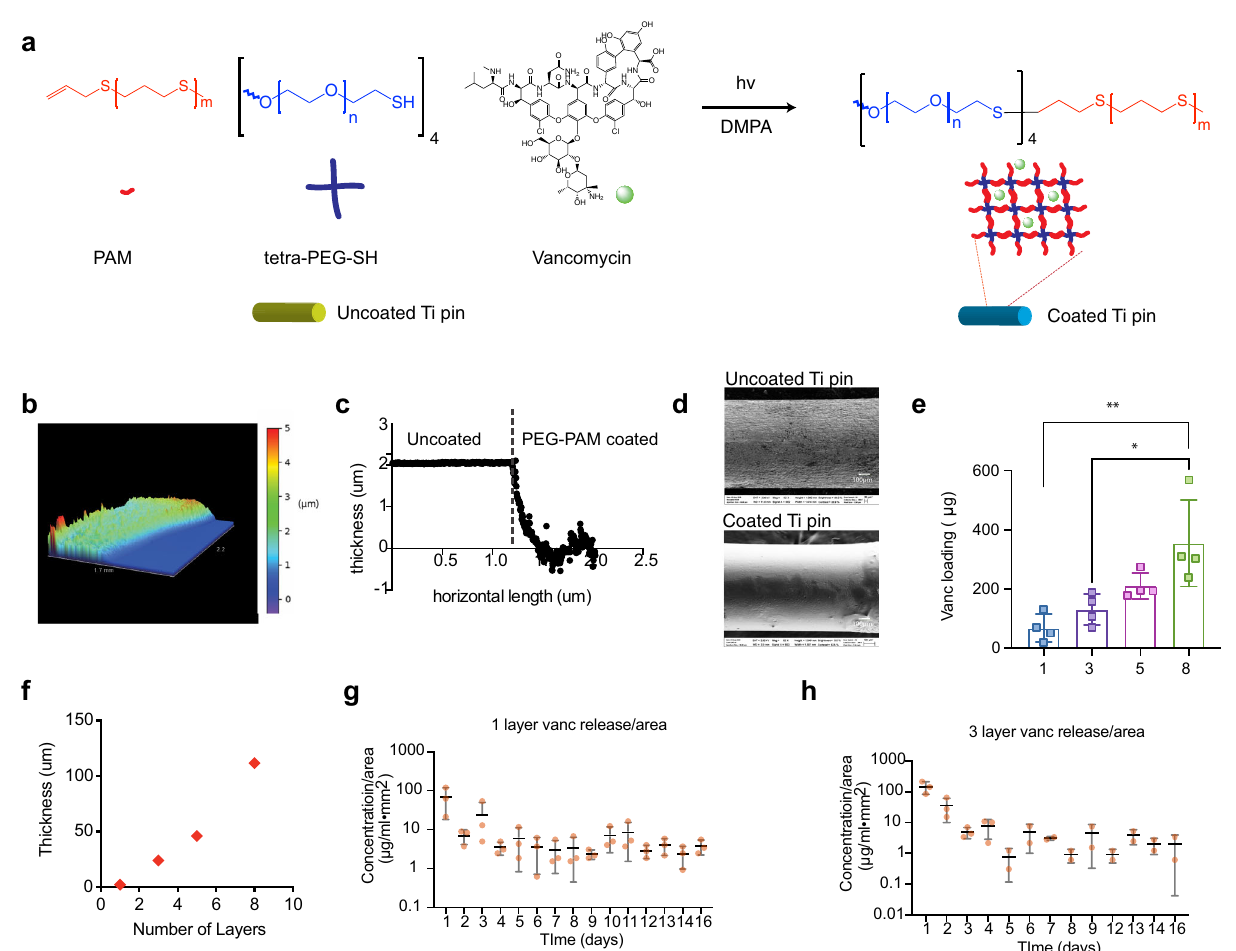
Fig. 2 PEG-PAM coating can be UV cured directly on to metal surfaces. a PAM, PEG-SH, and photoinitiator DMPA are dissolved in chloroform. The antibiotic (vancomycin for example) is also dissolved in chloroform. The surfaces (pin or fl at slide) are submerged in the coating solution and excess reagents removed by gravity, the surface is then exposed to UV light to induce PEG-PAM coupling. b 3D pro fi lometer scan of PEG-PAM coated titanium surface. c A horizontal and vertical measurement of coating thickness using the 3D pro fi lometer scan reveals a coating thickness of 2 µ m. d SEM images of uncoated and PEG-PAM/Vanc coated titanium pins show a change in surface roughness as a result of the coating process. e Multiple layer deposition of PEG-PAM polymer coatings (3 Layers, 5 Layers, and 8 Layers) with increased thickness and increased loading amount of vancomycin ( n = 4). f The thickness of 1, 3, 5, 8 layers of PEG-PAM coatings on the titanium surface ( n = 1). g In vitro release of vancomycin from single layer PEG-PAM coating ( n = 3). h In vitro release of vancomycin from 3 layers PEG-PAM coating ( n = 3). Statistics in ( e ) are an ordinary one-way ANOVA with a Tukey Multiple comparison test. ** p = 0.002 and * p = 0.012. Data is plotted showing the Mean and Standard Deviation. Biological replicates derived from independent experiments are shown in each panel as a